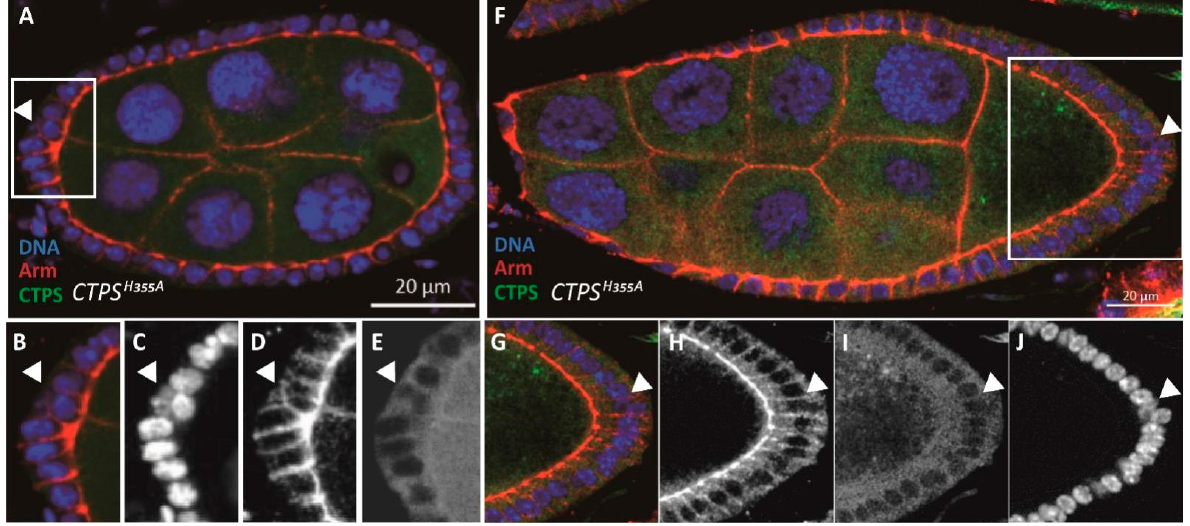
Figure 3. Follicle cell ingression in CTPS H355A mutant in early and middle stages of oogenesis. ( A ) Cross section of a CTPS H355A stage 6 egg chamber. The egg chamber is labeled with CTPS (green), Armadillo (red) for apical complex in follicle cells and Hoechst 33342 (blue) for DNA. The white rectangle emphasizes the ingression of a follicle cell. ( B – E ) Close-up images of the ingressive follicle cell, indicated by the yellow arrow. No cytoophidium is formed due to the H355A mutation in CTPS. ( F ) Cross section of a CTPS H355A egg chamber at stage 9. The white rectangle emphasizes the ingression of a follicle cell. ( G – J ) Close-up images of the ingressive follicle cell, indicated by the yellow arrow. Scale bars, 20 µ